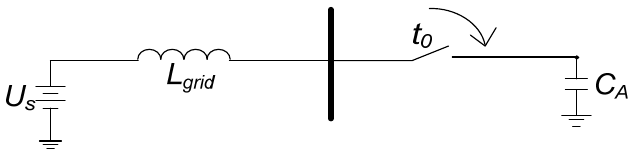
Figure 11. Simplified schematic of the connection of cable A, when no cables are